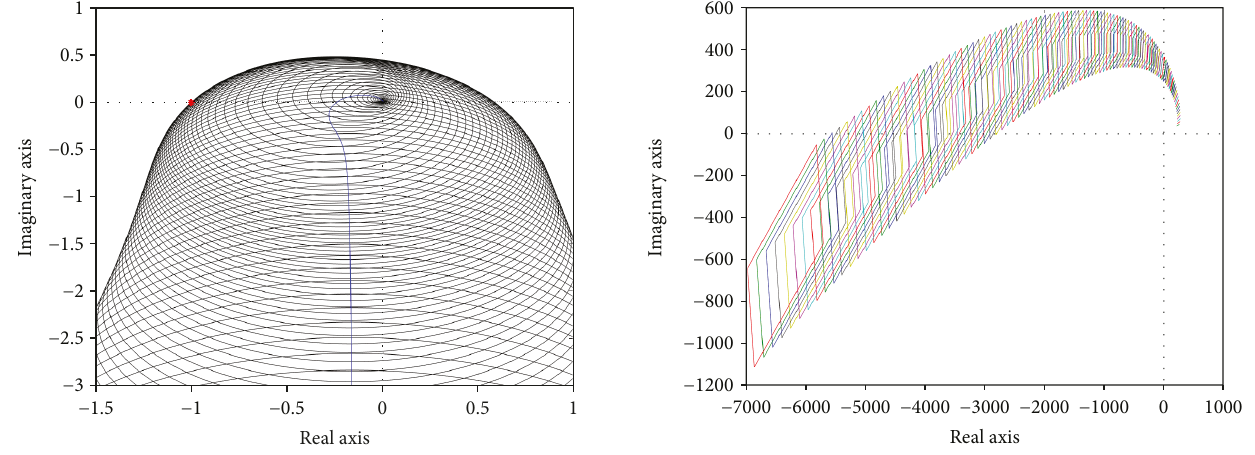
Figure 14: Value sets of the FO family of polynomials